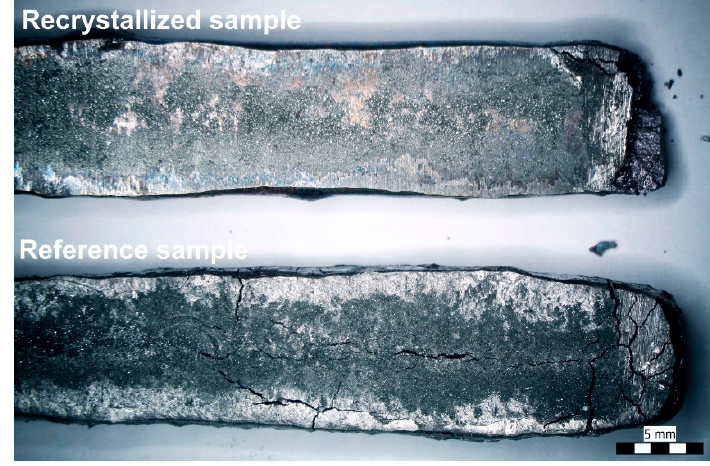
Figure 5. A reference and a recrystallized sample after being stored at − 10 °C for 40 weeks.